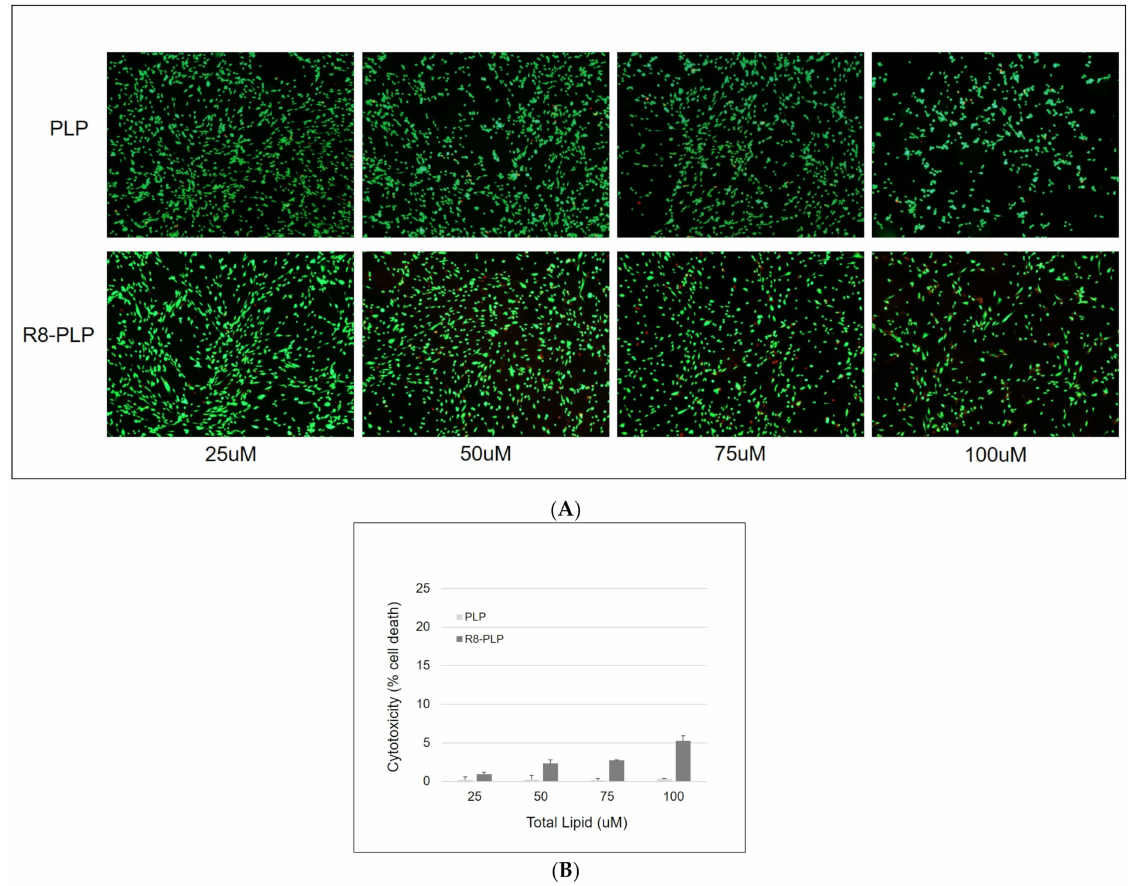
Figure 10. R8-PLP nanoparticles demonstrated negligible cytotoxic effects in vitro under ( A ) qualitative and ( B ) quantitative